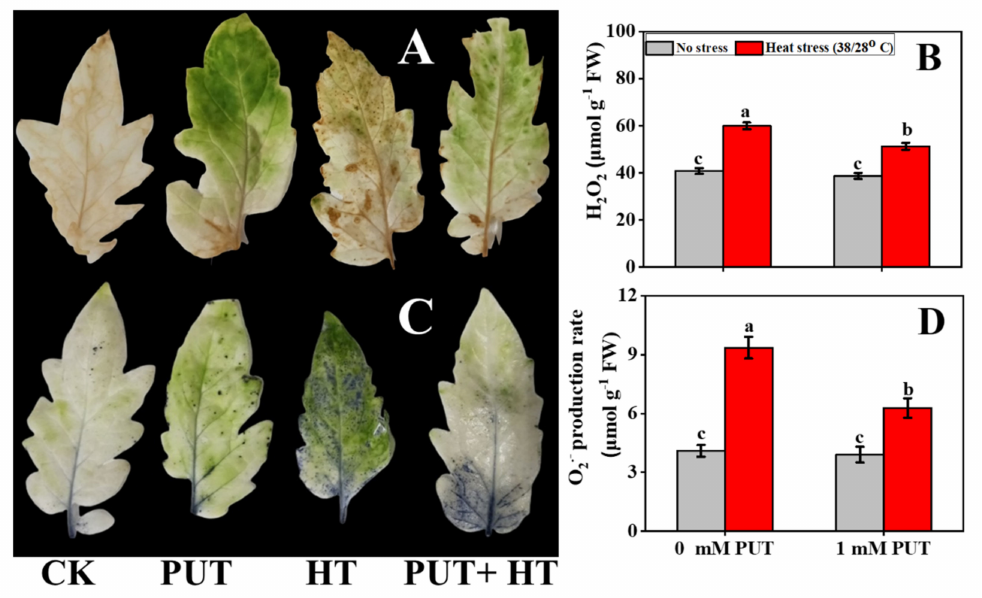
Figure 7. Interactive effects of Putrescine and high temperature on ( A ) Accumulation of hydrogen peroxide, ( B ) Hydrogen peroxide content, ( C ) Accumulation of superoxide anion, and ( D ) Superoxide anion production rate in tomato seedlings. The data denote the mean value ± standard error (n = 3). Different alphabetic letters represent significant differences among the treatments at p < 0.05, according to Tukey’s